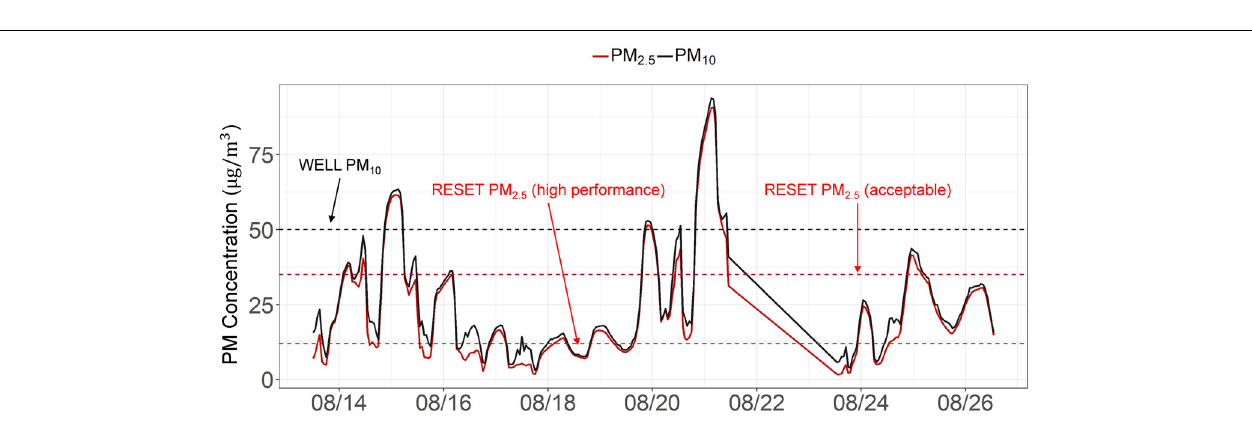
Frontiers in Built Environment |